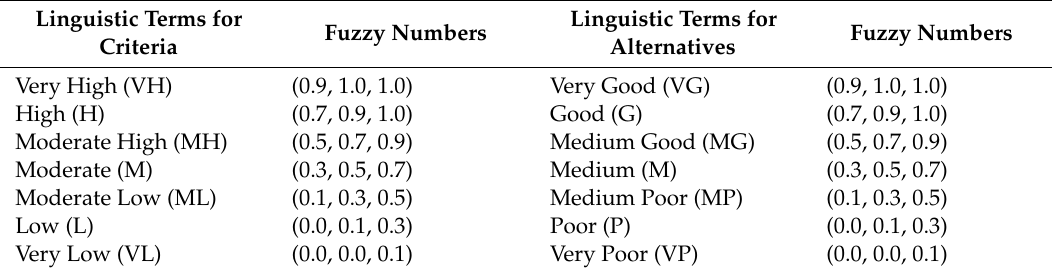
Table 6. Linguistic terms for criteria and alternatives. Linguistic Terms for Linguistic Terms for Fuzzy Numbers Fuzzy Numbers Alternatives Criteria Very High (VH) (0.9, 1.0, 1.0) Very Good (VG) (0.9, 1.0, 1.0) High (H) (0.7, 0.9, 1.0) Good (G) (0.7, 0.9, 1.0) Moderate High (MH) (0.5, 0.7, 0.9) Medium Good (MG) (0.5, 0.7, 0.9) Moderate (M) (0.3, 0.5, 0.7) Medium (M) (0.3, 0.5, 0.7) Moderate Low